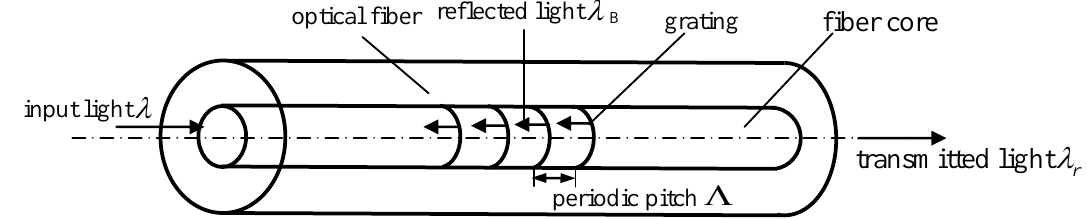
Figure 3. The structure of FBGs